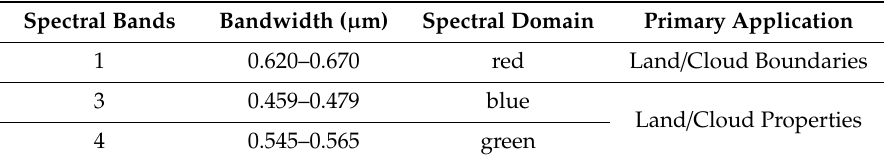
Table 1. Characteristics of MODIS spectral bands 1, 3, and 4.